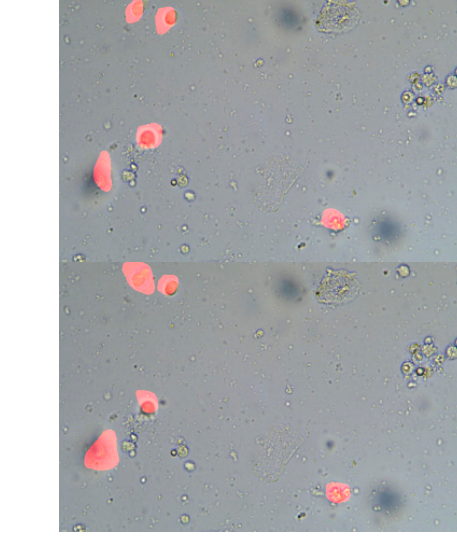
Figure 4. Examples of the generated random rough detection results. For convenience of display, we have used red to mark the TV regions on the original image. ( a ) Ground truth of TV; ( b ) two examples of the generated rough detection result.